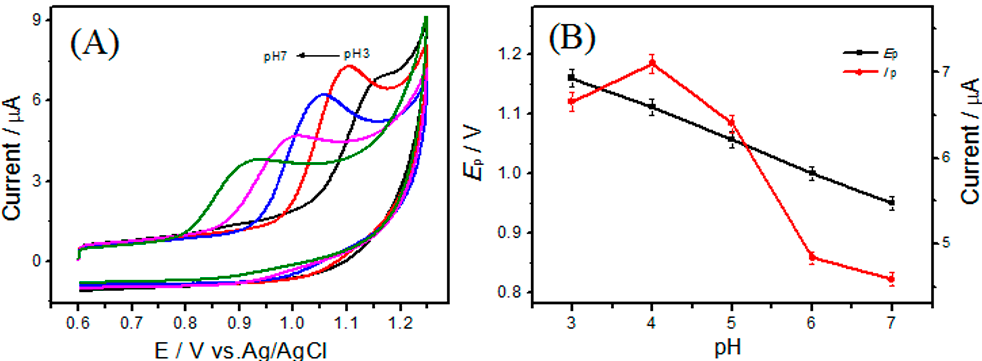
Figure 4. ( A ) CV curves of TiC/C-modified electrode in 0.1 M PBS in the present of 10 µ M PMT with different pH values. ( B ) The effect of pH on the formal potential and anodic peak current.